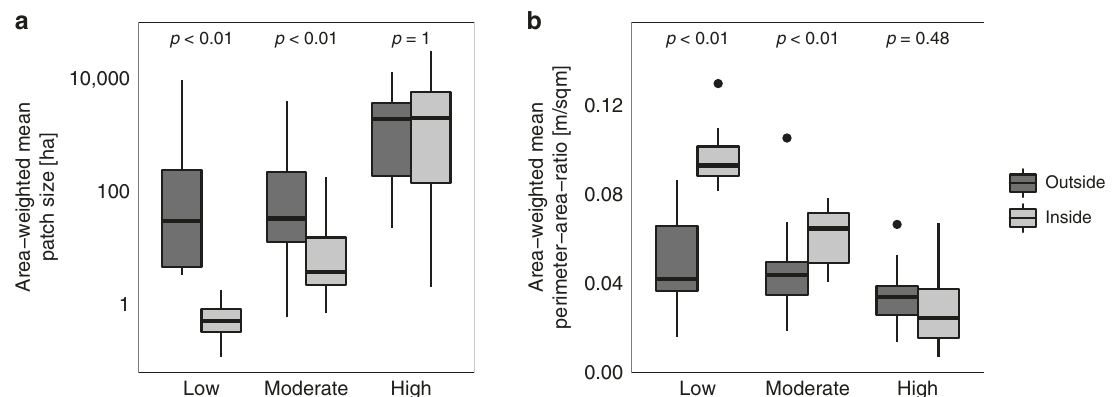
Fig. 3 Comparison of disturbance patterns inside and outside protected areas. a Area-weighted mean patch size and b area-weighted mean perimeter- area-ratio are compared for areas inside and outside protected areas for three global clusters of disturbance activity (cf. Table 1). Boxplots denote the median (center line) and interquartile range (box), with whiskers extending to three times the interquartile range and points indicating values outside this range. Test statistics and p -values are based on approximate Kruskal – Wallis tests with